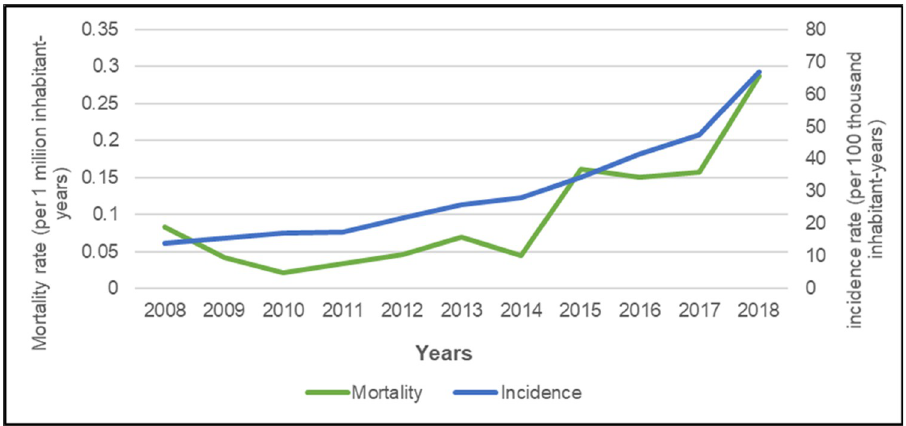
Fig 2. Incidence and mortality rates of scorpion envenomations per year in the state of S ã o Paulo, Brazil from 2008–2018.